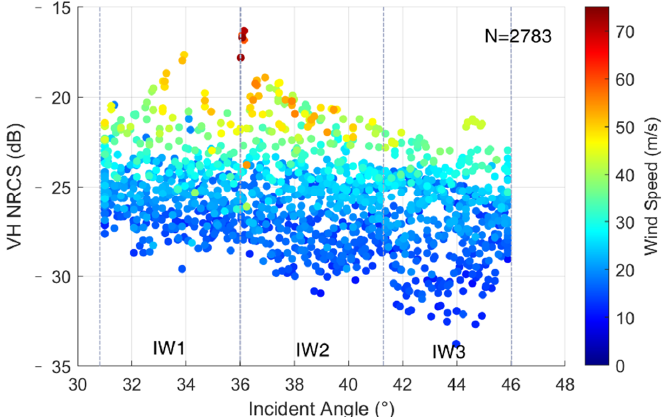
Figure 2. The distributions of VH NRCS, incident angle, and wind speed in different sub-swaths in Dataset 1. The total number of matching points was 2783.